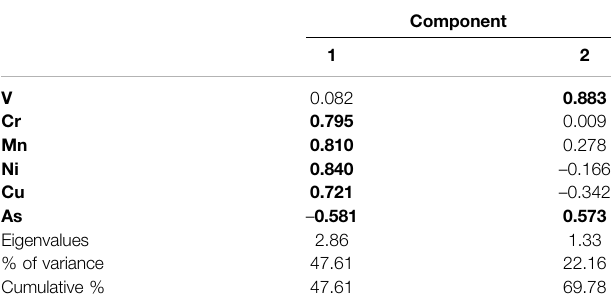
TABLE 7 | Varimax rotated component matrix for selected trace elements in the studied river water.